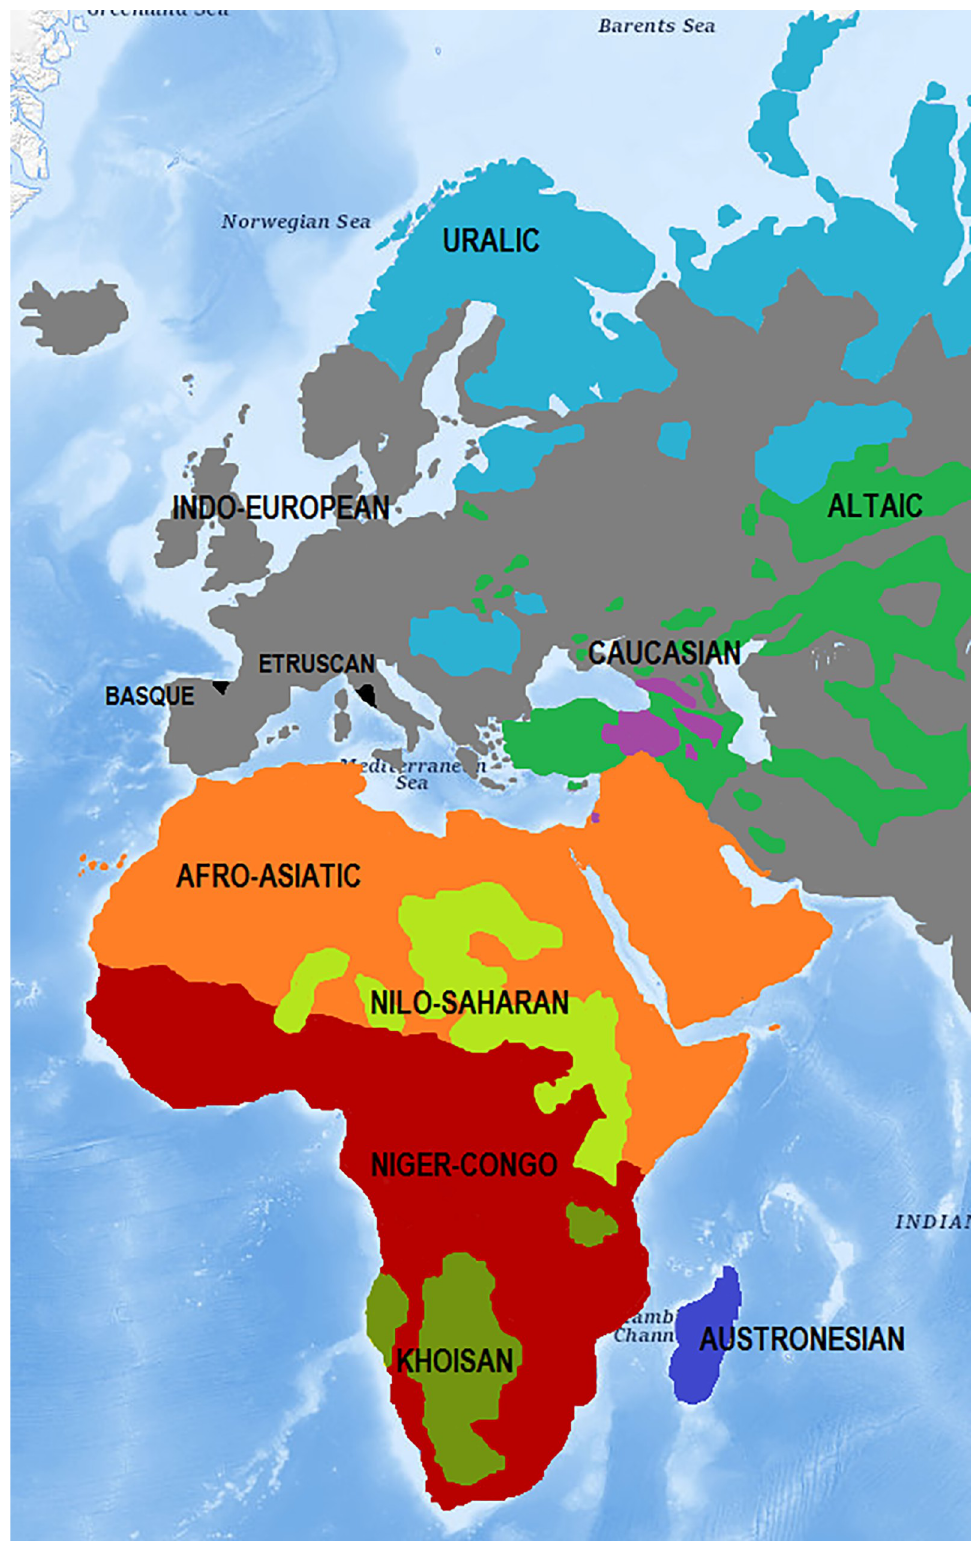
Fig 1. Map of linguistic phyla considered in their geographical environment: Europe, Africa and Western Asia [17] (modified figure, similar but not identical to the original for illustrative purposes). https://doi.org/10.1371/journal.pone.0213710.g001 PLOS ONE | https://doi.org/10.1371/journal.pone.0213710 March 19,